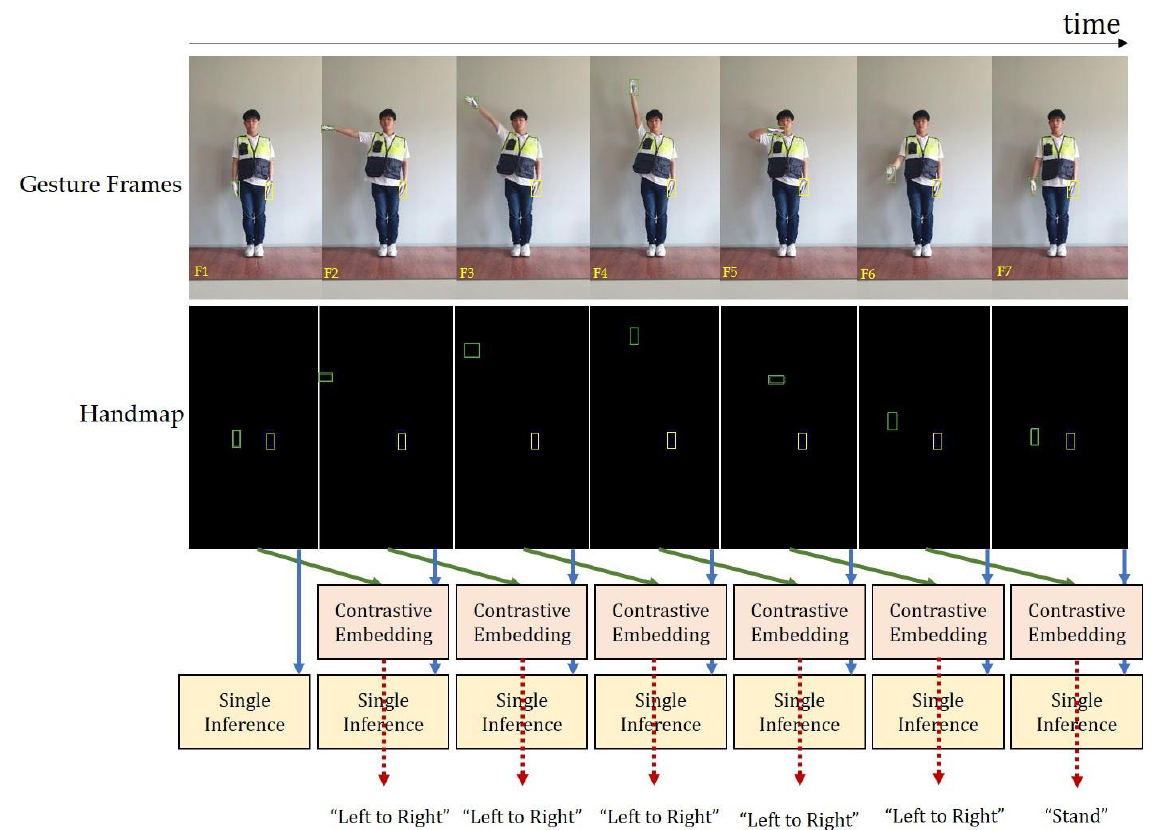
Figure 10. Frame-by-frame hand gesture recognition in stage 3 of the proposed approach. In this particular example, seven frames ( F1 – F7 ) have constituted a complete “left to right” traffic control hand gesture. Each gesture recognition is achieved by combining the contrastive embedding and single inference predictions.